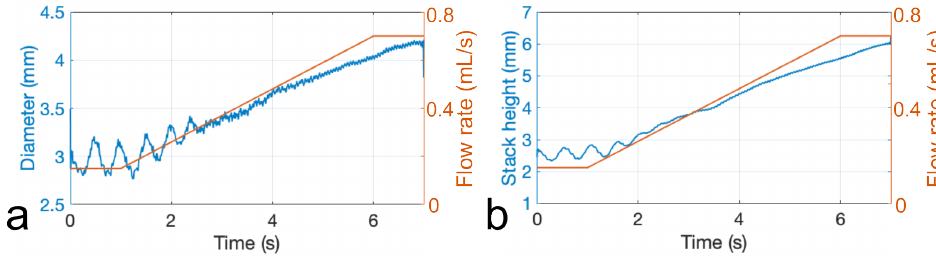
Figure 9. Stack height and width increasing as a result of increasing flow rate. Honey at an initial, steady flow rate of 0.15 mL · s − 1 increased to 0.7 mL · s − 1 at a fall height of 6 cm. ( a ) Stack height increasing over time as the flow rate increased and ( b ) the corresponding increase in stack width over